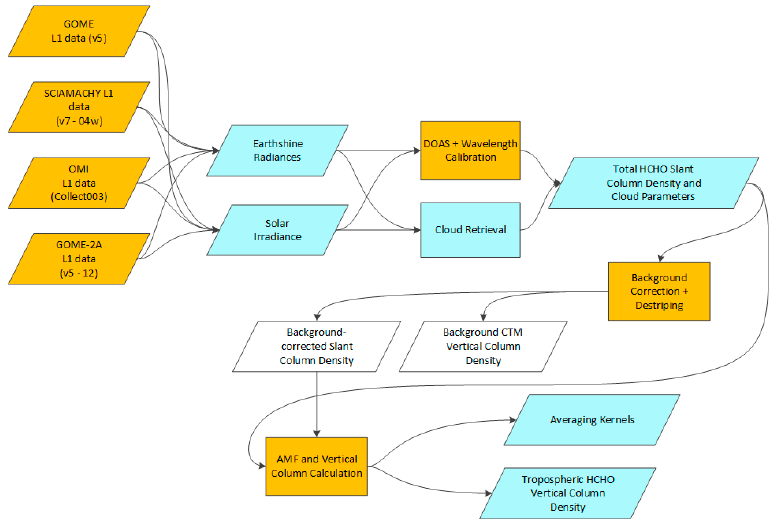
Figure 10 . QA4ECV formaldehyde (HCHO) product top-level traceability chain. CTM: chemical transport model.